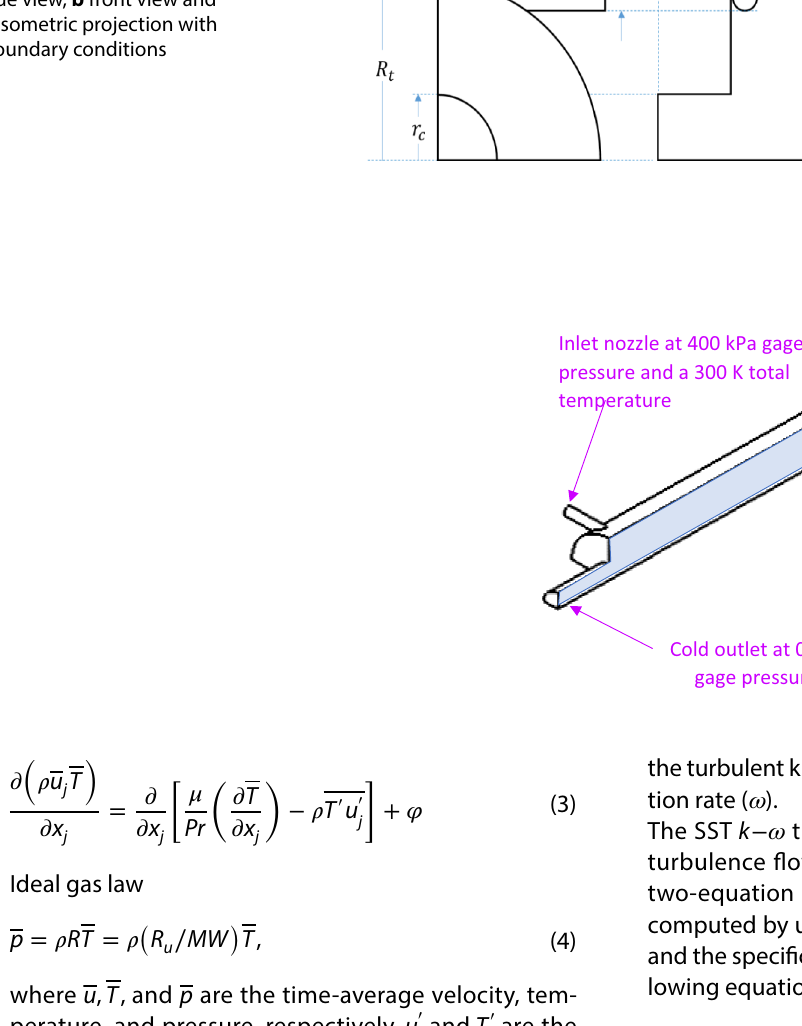
Fig. 1 A two-dimensional schematic of the vortex tube with its main dimensions a side view, b front view and c isometric projection with boundary conditions